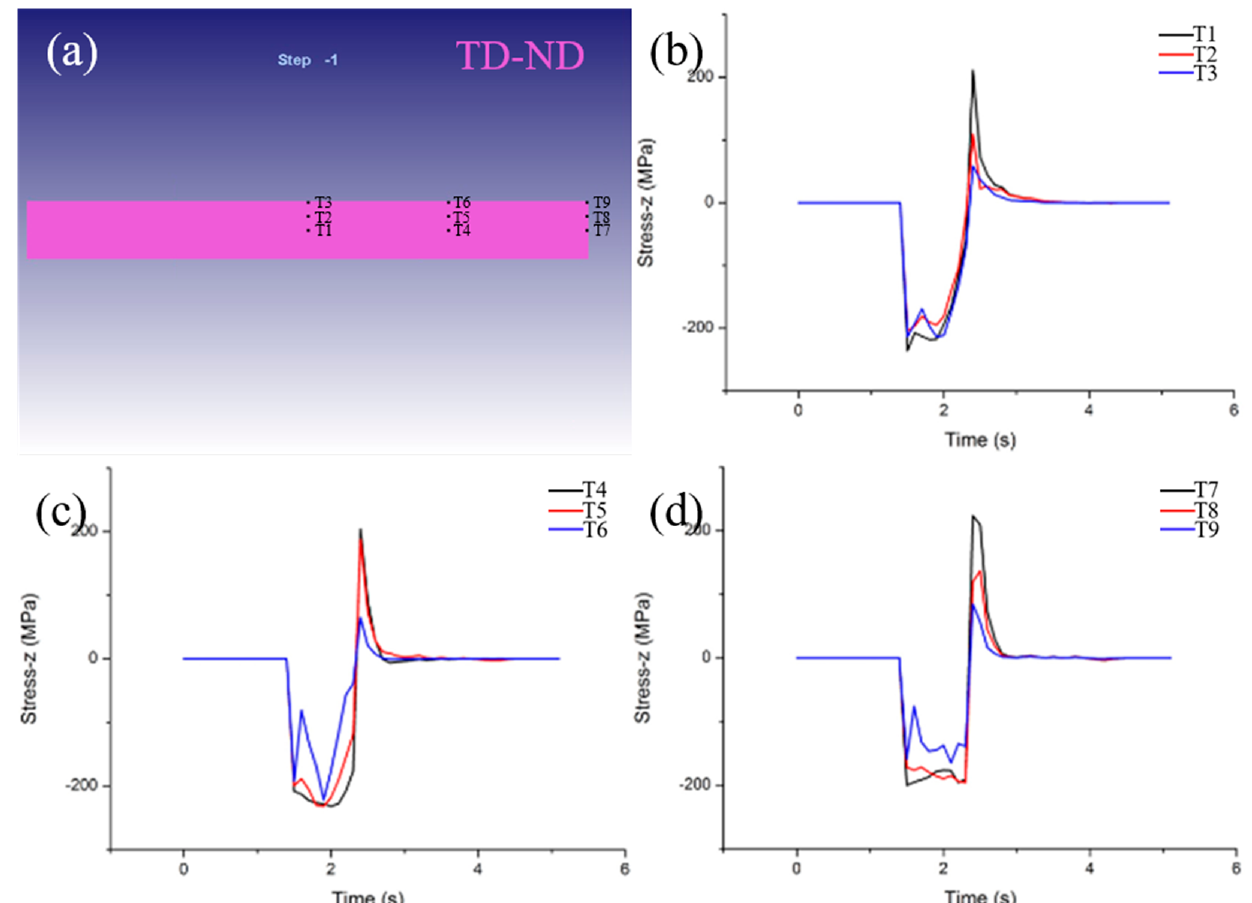
Figure 7. Distribution of characteristic points on TD − ND plane ( a ), the additive stress distribution along ND direction at set point on TD − ND plane at 1400 °C and 20% reduction ( b – d ). In order to study the effect of the rolling process on transverse crack formation, three points of T1, T2 and T3 in TD − ND plane were selected to simulate and analyze additive tensile stress at different rolling temperatures and reduction, as shown in Figure